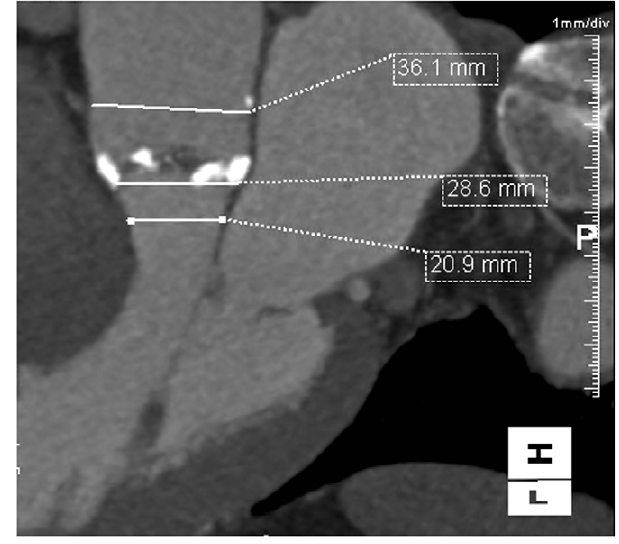
Figure 2. LVOT view of aortic annulus. Calcium nodules at the annulus with annular dimension of 28.6 mm (the other dimension not here shown is 29 mm), patient eventually had a 31 mm CoreValve R (cid:13) device implanted. tortuosity. Intravascular ultrasound is likewise limited by poor intra-abdominal visualisation. MDCT allows 3D and multiplanar reconstruction of the ilio-femoral vessels [19] and aorta (Fig. 1). French expandable for Edwards SAPIEN XT) used to access the ilio-femoral